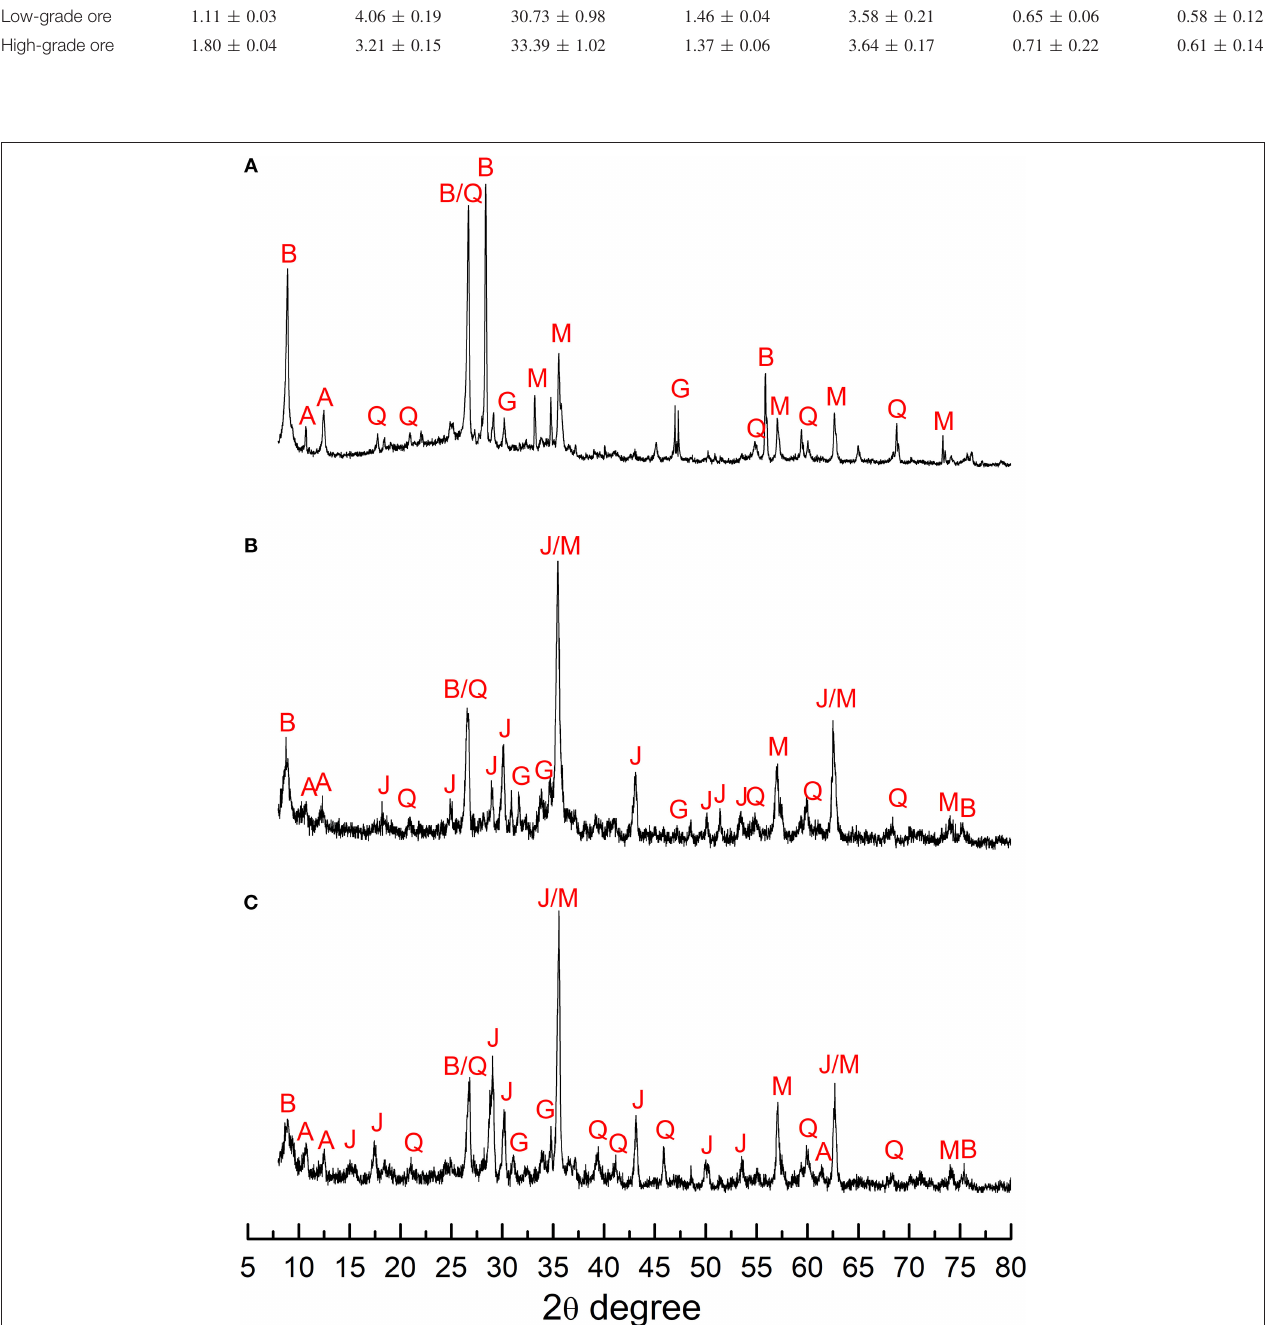
FIGURE 1 | XRD analysis of the original sample (A) and the leaching residues of the non-inoculated (B) and reference (C) columns. Experiments with the high-grade ore. A, grunerite or greenalite; B, biotite; J, K-jarosite; Q, quartz; G, garnet; M, magnetite.